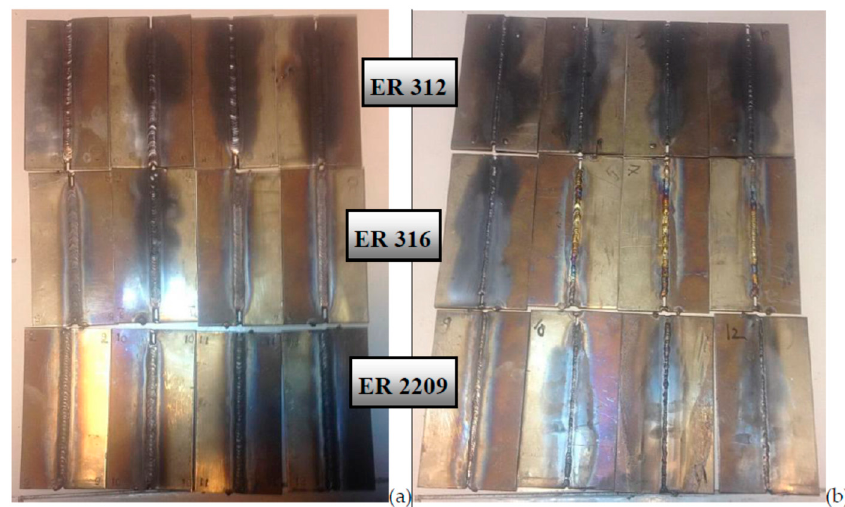
Figure 2. Welded specimens ( a ) front sides; ( b ) back sides.